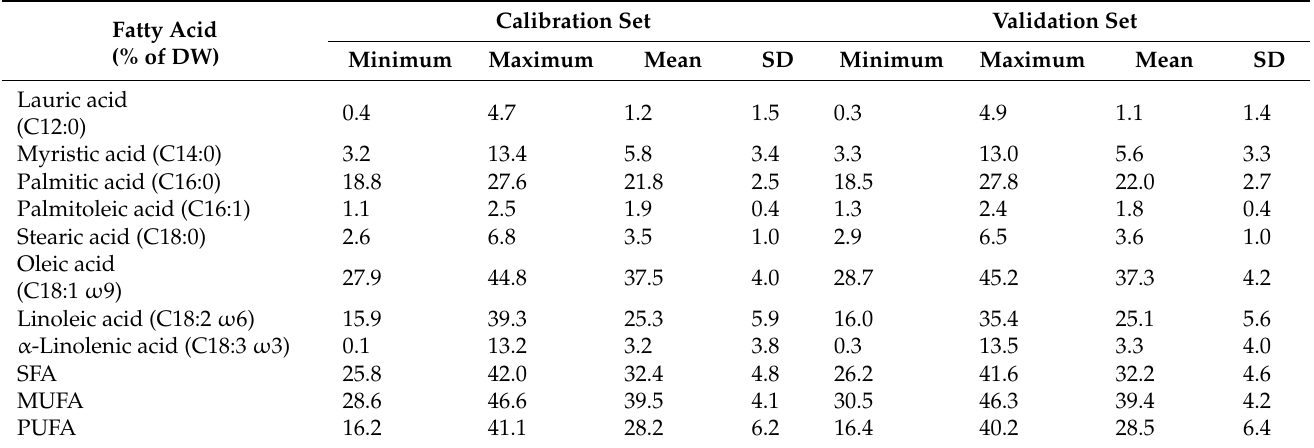
Table 6. Fatty acid content on a dry weight (DW) basis (%) of living Tenebrio molitor larvae for the calibration ( n = 80) and validation sets ( n = 40).